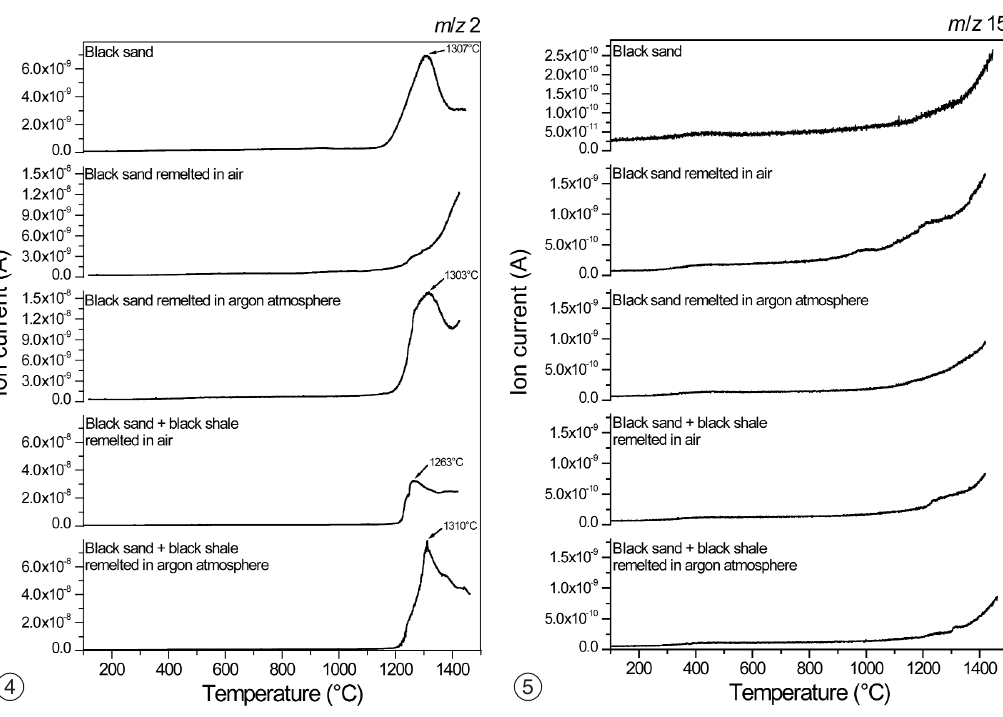
Fig. 4. Hydrogen ( m / z = 2) release profiles from black sand and remelting products. Fig. 5. Degassing profile of hydrocarbon fragment of methane CH 3 + -( m / z = 15) from black sand and remelting